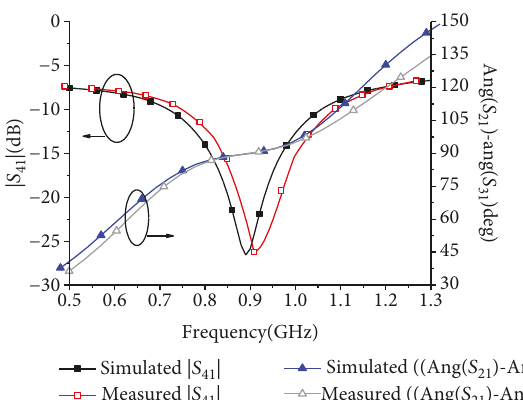
Figure 15: Simulated and measured S